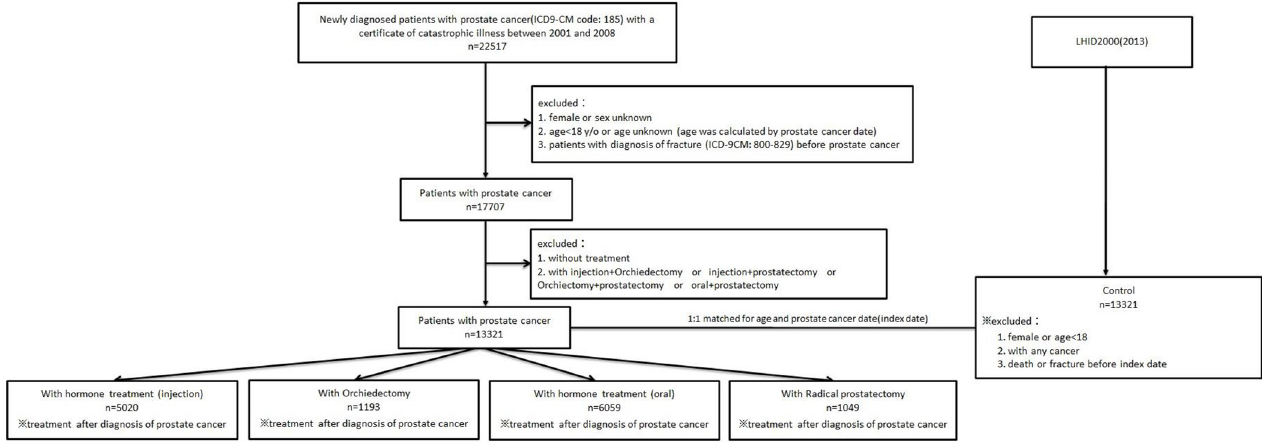
Fig 1. Flow diagram showing the process of fracture patient sampling and